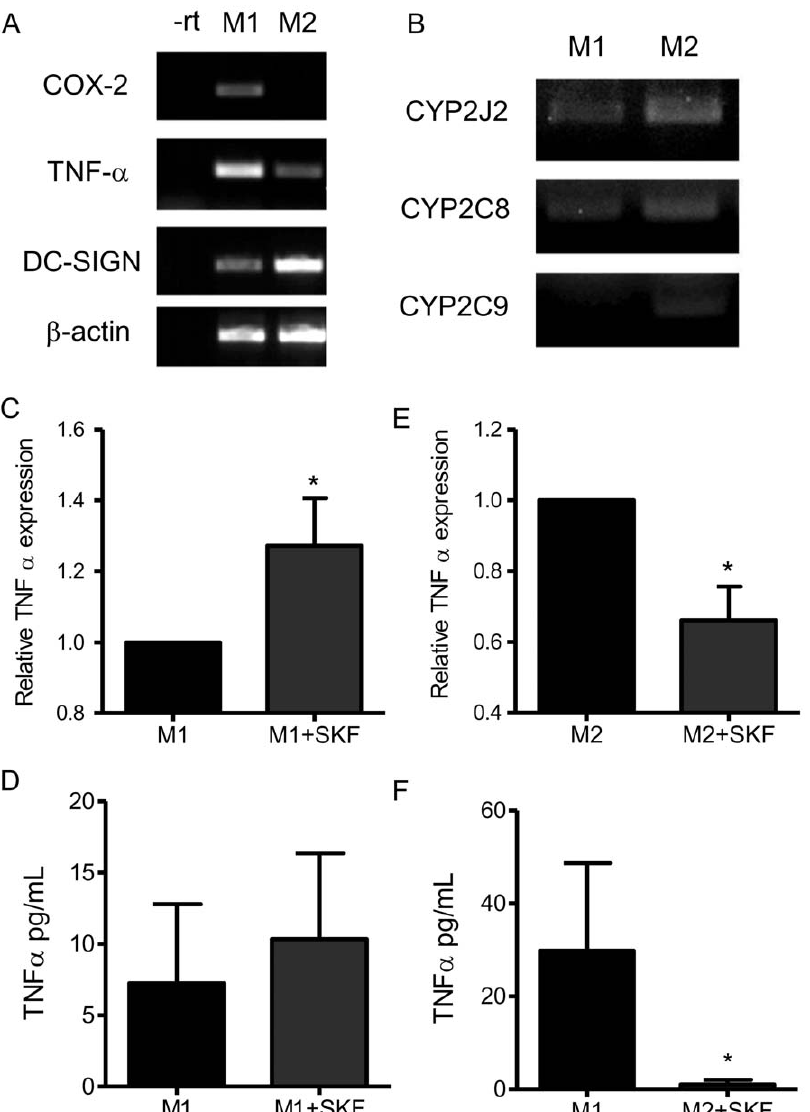
Figure 6. Epoxygenase inhibition differentially regulates the release of TNF a from M1 and M2 macrophages. (A) Differentiation of human peripheral blood mononuclear cells for 7d with either LPS (1 ng/ml) and IFN c (20 ng/ml; M1) or IL-4 (20 ng/ml; M2) induces a characteristic pattern of M1 (high COX-2, high TNF a , low DC-SIGN) and M2 (low COX-2, low TNF a and high DC-SIGN) macrophage differentiation. Markers were measured by RT-PCR compared to b -actin. (B) CYP2J2 and CYP2C8 mRNA are expressed in M1 and M2 macrophages. In addition CYP2C9 is expressed in (2 out of 4) macrophages. Blots are representative of n=4 independent experiments. (C-F) TNF a mRNA (top) and protein (lower panels) is differentially regulated in M1 (C and D): primary M1 macrophages (C) and M1-THP-1-macrophages (D), and M2 (E and F): primary M2 macrophages (E), and M2-THP-1 (F) macrophages treated with SKF525A (10 m M). Monocytes were placed in differentiation medium containing vehicle or SKF525A for 7d. M1 and M2-THP-1 cells were identically treated with M1 or M2 differentiation media, however in these experiments, SKF525A (10 m M) was given to fully differentiated cells at the end of the experiment on day 7 for a further 7 h. The relative TNF a mRNA compared to b -actin levels was measured by RT-PCR. TNF a release was determined by ELISA. *denotes p , 0.05, by one-sample t-test compared to untreated